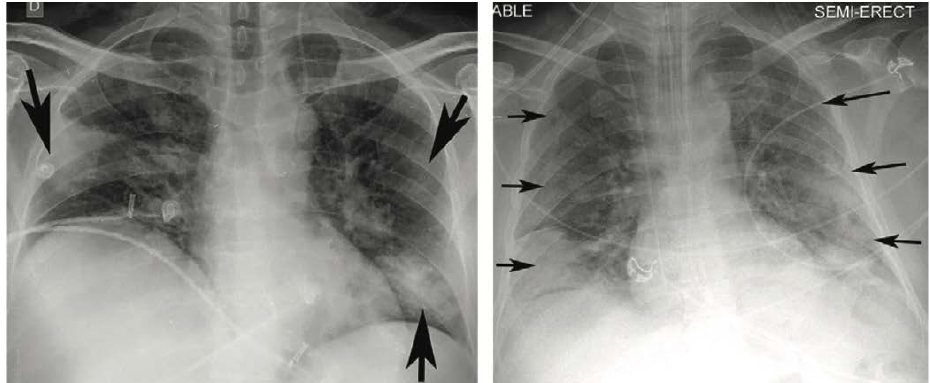
Figure 1. Typical appearances of COVID-19 in the form of lung opacities. CXR images obtained from the RICORD data set [10]. Arrows pointing to the